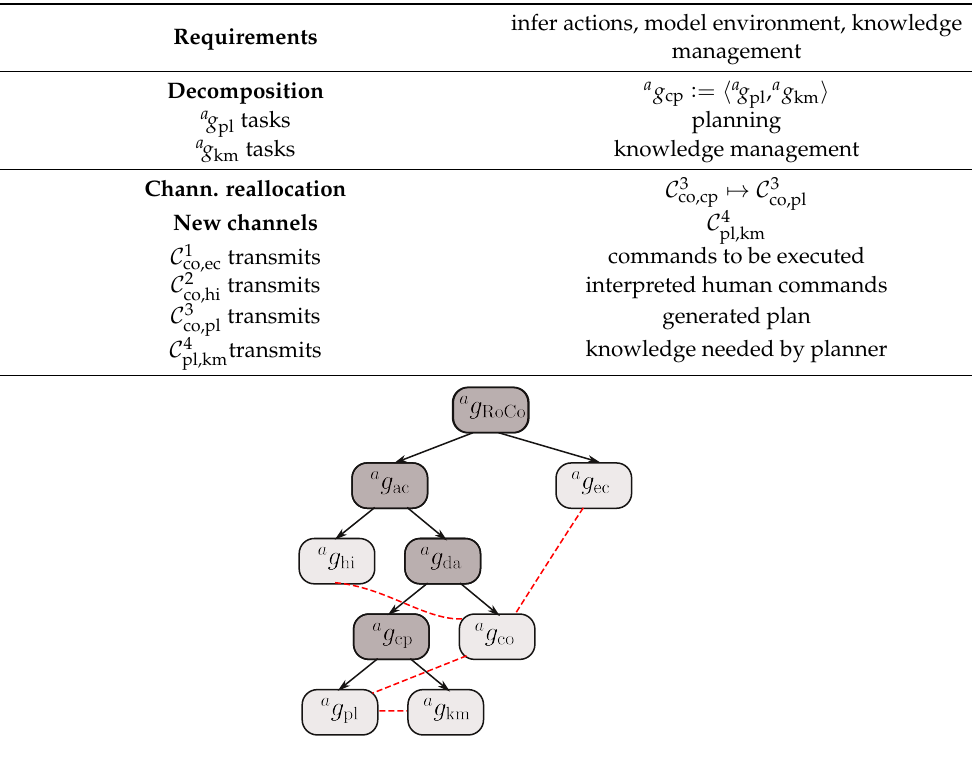
Table 2. Summary of the fourth step— a g cp